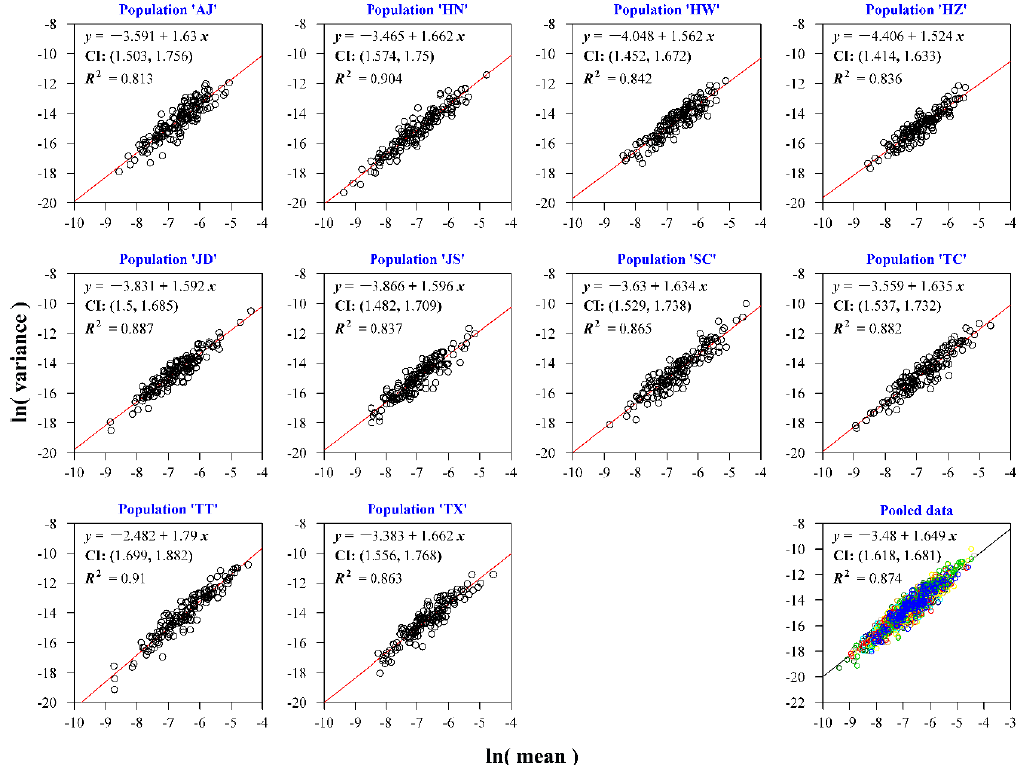
Figure 2. Taylor’s power law for the measure of leaf bilateral symmetry for 10 populations of P. subaequalis (Hamamelidaceae). The two-letter title of every panel represents the population code (see Table S1 for details). The small open circles represent the observations, and the straight line represents the fitted regression line based on the ordinary least-squares method. ‘ CI ’ represents the 95% confidence interval of the estimate of the slope of the fitted linear equation.